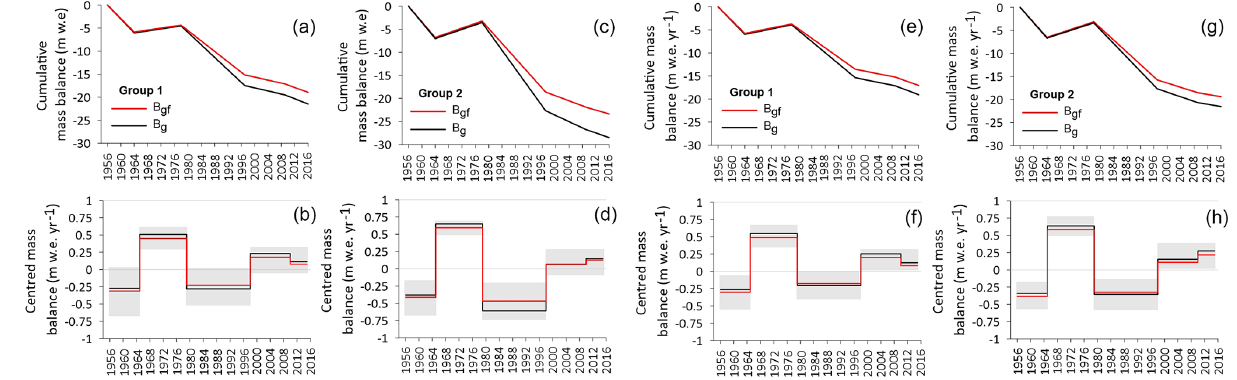
Figure 7. Cumulative mass balance and centred mass balance of the glaciers in Group I (including G5 in panels a and b and excluding G5 in panels e and f ) and of the glaciers in Group II (including G1a and G16 in panels c and d and excluding G1a and G16 in panels g and h ). The black line represents the conventional balance, and the red line represents the fixed mass balance. The grey-shaded areas represent the standard deviation of the mass